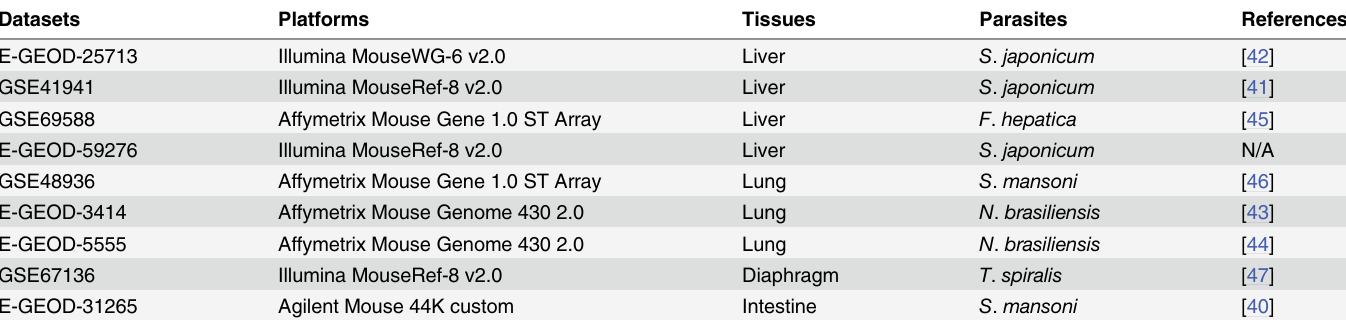
Table 1. The nine public gene expression datasets included in our